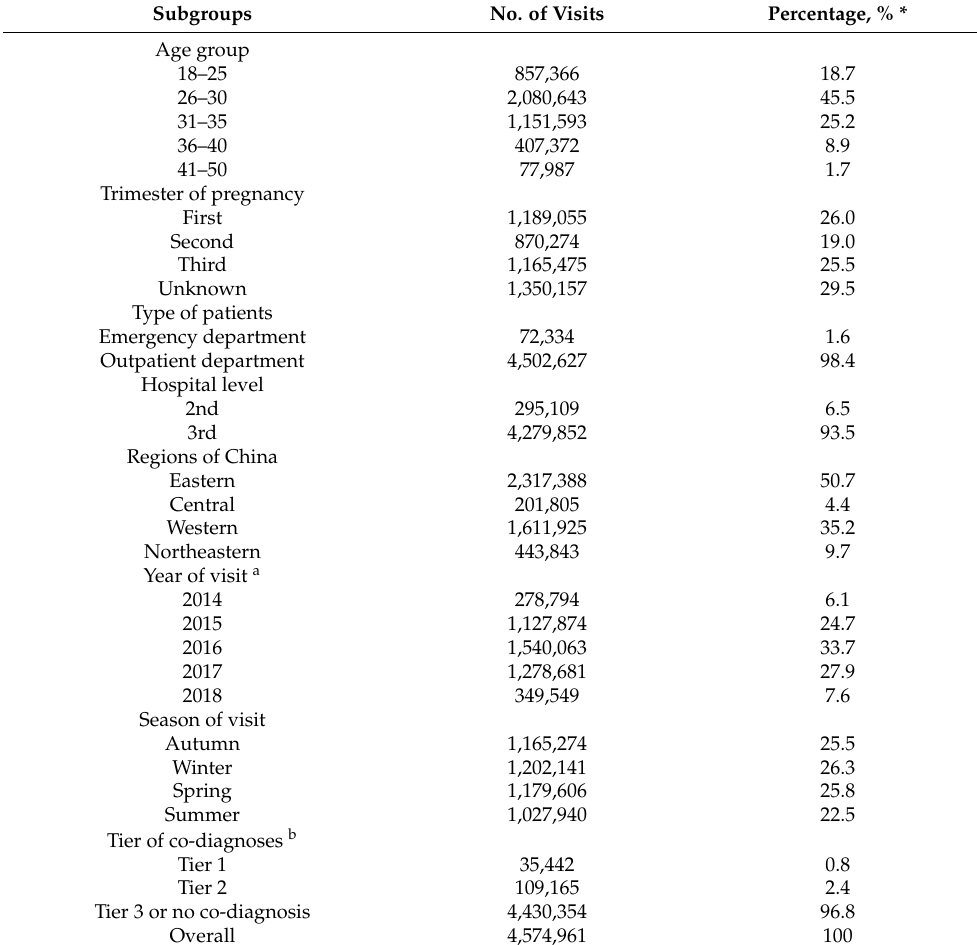
Table 1. Basic characteristics of ambulatory care visits during